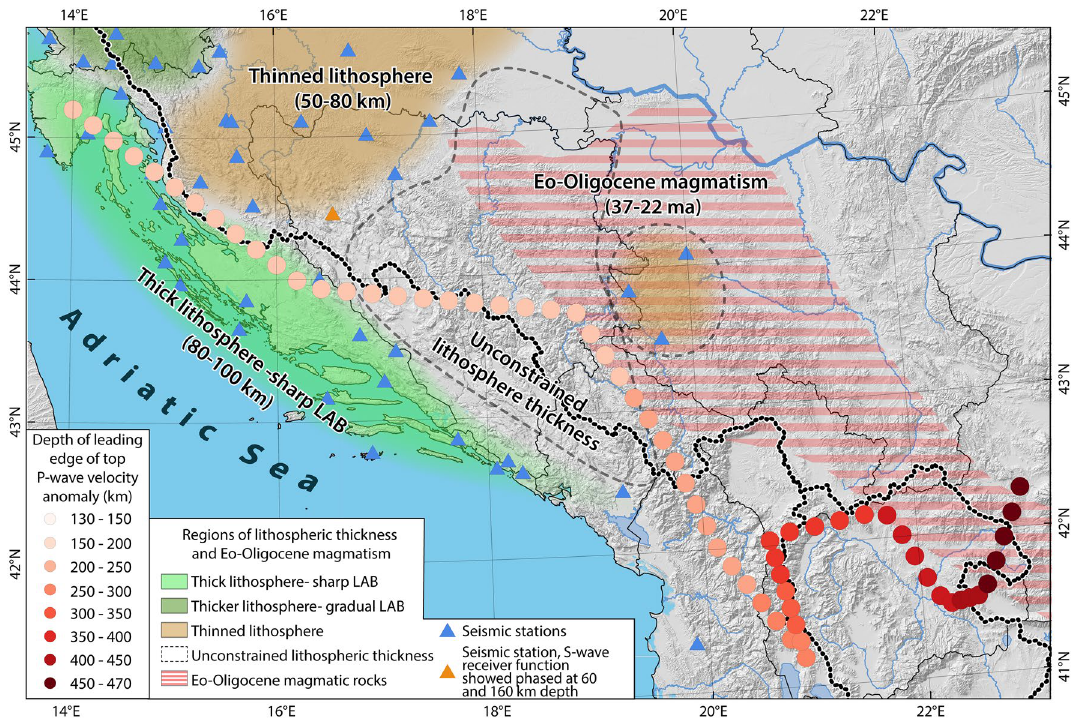
Figure 7. DEM 34 of the Dinarides showing regions of different lithosphere thicknesses, modified after Belinić, et al. 45 , the domain of Eo-Oligocene magmatic rocks after Handy, et al. 20 , the depth and position of the leading edge of the mapped high velocity P-wave anomaly and the drainage divide. The dark green regions are associated with a thick lithosphere and a gradual LAB (northern Dinarides), the light green regions are related to a thick lithosphere (most External Dinarides) and sharp LAB and the brown regions are related to a thinned lithosphere (Internal Dinarides). The red striped region shows the location of Eo-Oligocene magmatic rocks with mantle